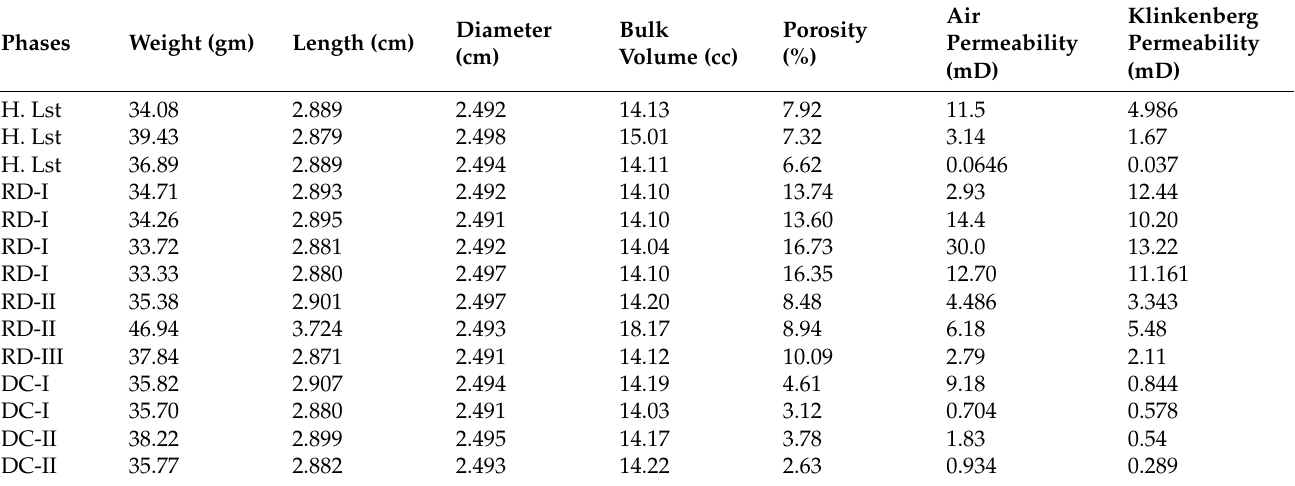
Table 4. Porosity (%) and permeability (mD) values of the investigated dolomite phases calculated from plug